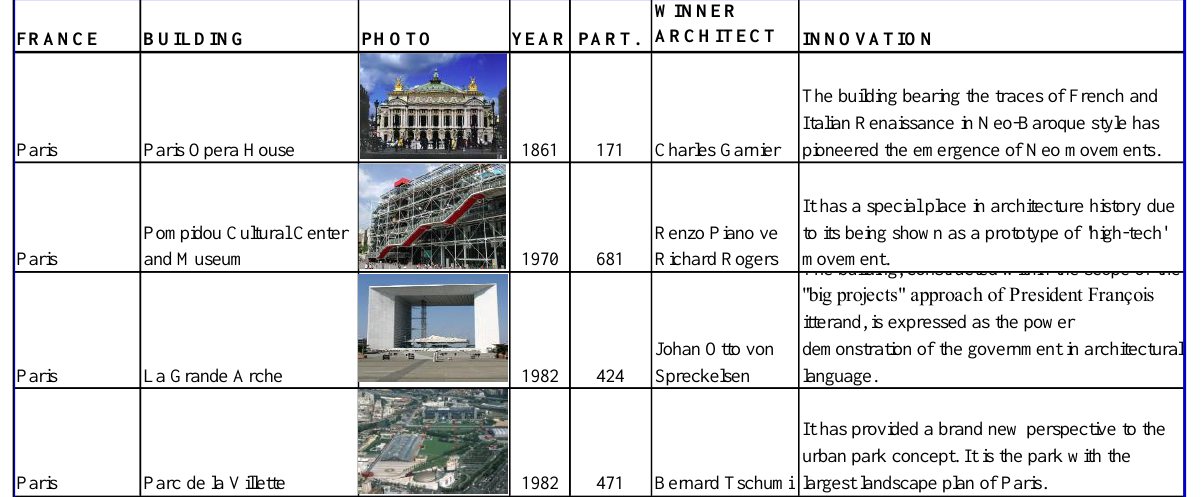
Table 3. Selected competition examples from France